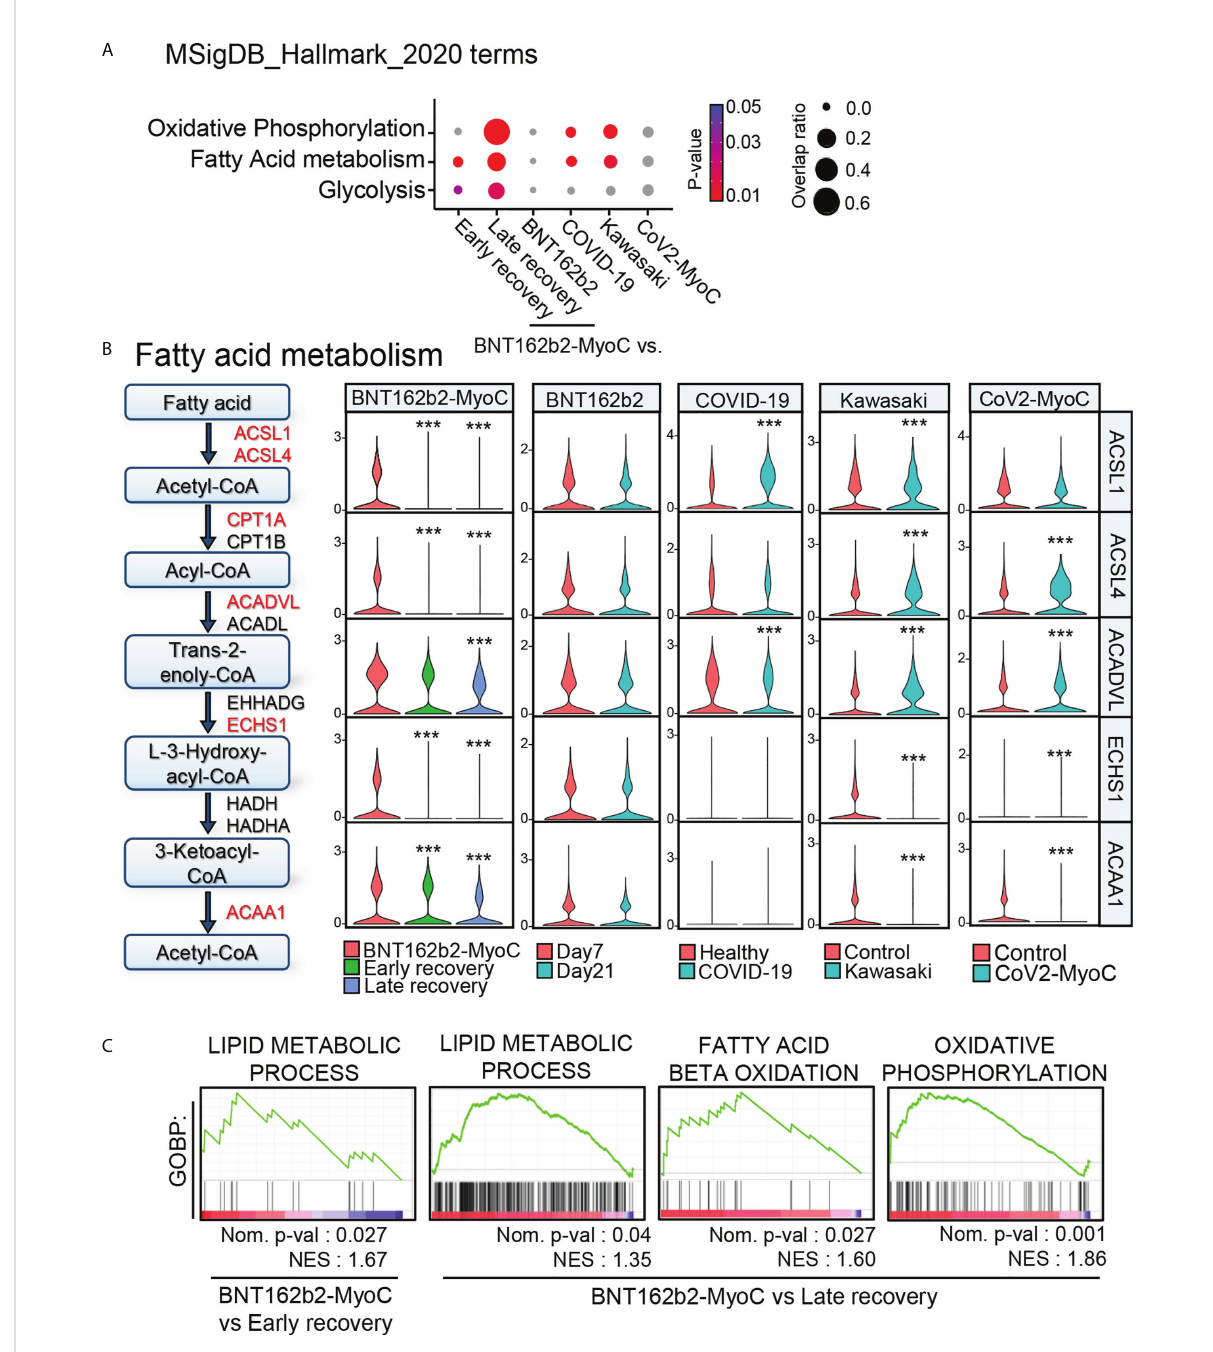
FIGURE 4 Fatty Acid Metabolism is Highly Up-regulated in Classical Monocytes in BNT162b2-MyoC Stage. (A) Enrichment analysis with cellular metabolism-related Hallmark gene sets for DEGs of classical monocytes in each dataset. (B) A diagram offatty-acid metabolism-pathway and violin plots showing the expression levels of the pathway-related genes in classical monocytes. *** p < 0.001; two-tailed t test. (C) GSEA analysis for the dataset of DEGs of classical monocytes in BNT162b2-MyoC group was conduct against GOBP_LIPID_METABOLIC_PROCESS, GOBP_OXIDATIVE_PHOSPHORYLATION, and GOBP_FATTY_ACID_BETA_OXIDATION gene sets, respectively. A positive enrichment score on the y axis indicates positive correlation with BNT162b2- MyoC